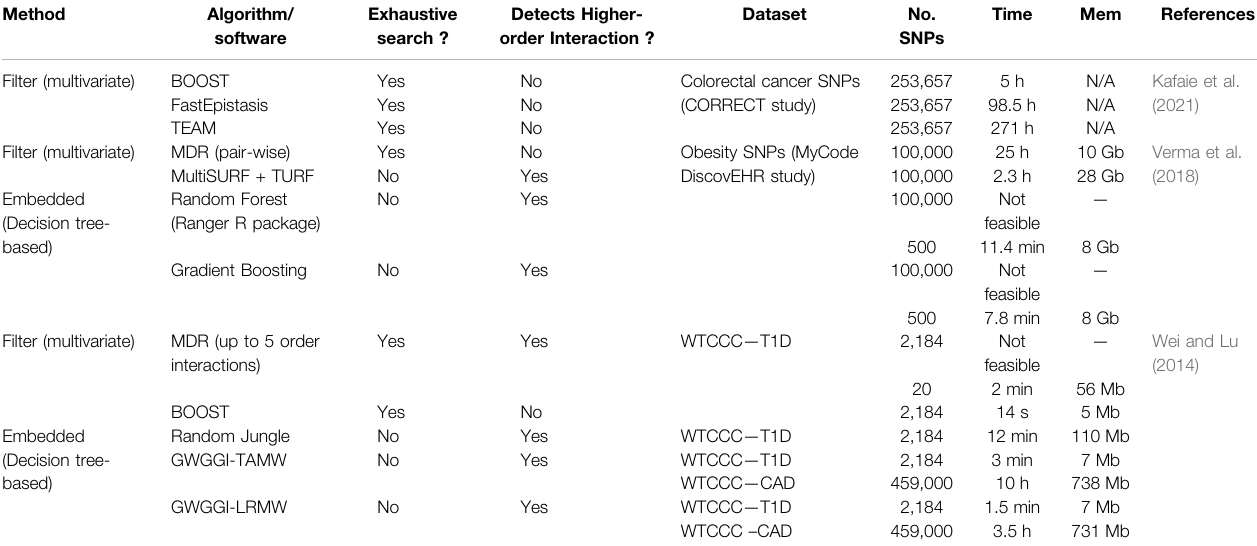
TABLE 2 | Summary of algorithms reviewed to detect epistasis along with datasets applications, computational time, and memory requirements. Data are taken from three comparative studies, each of which are colour coded differently. N/A, not available.